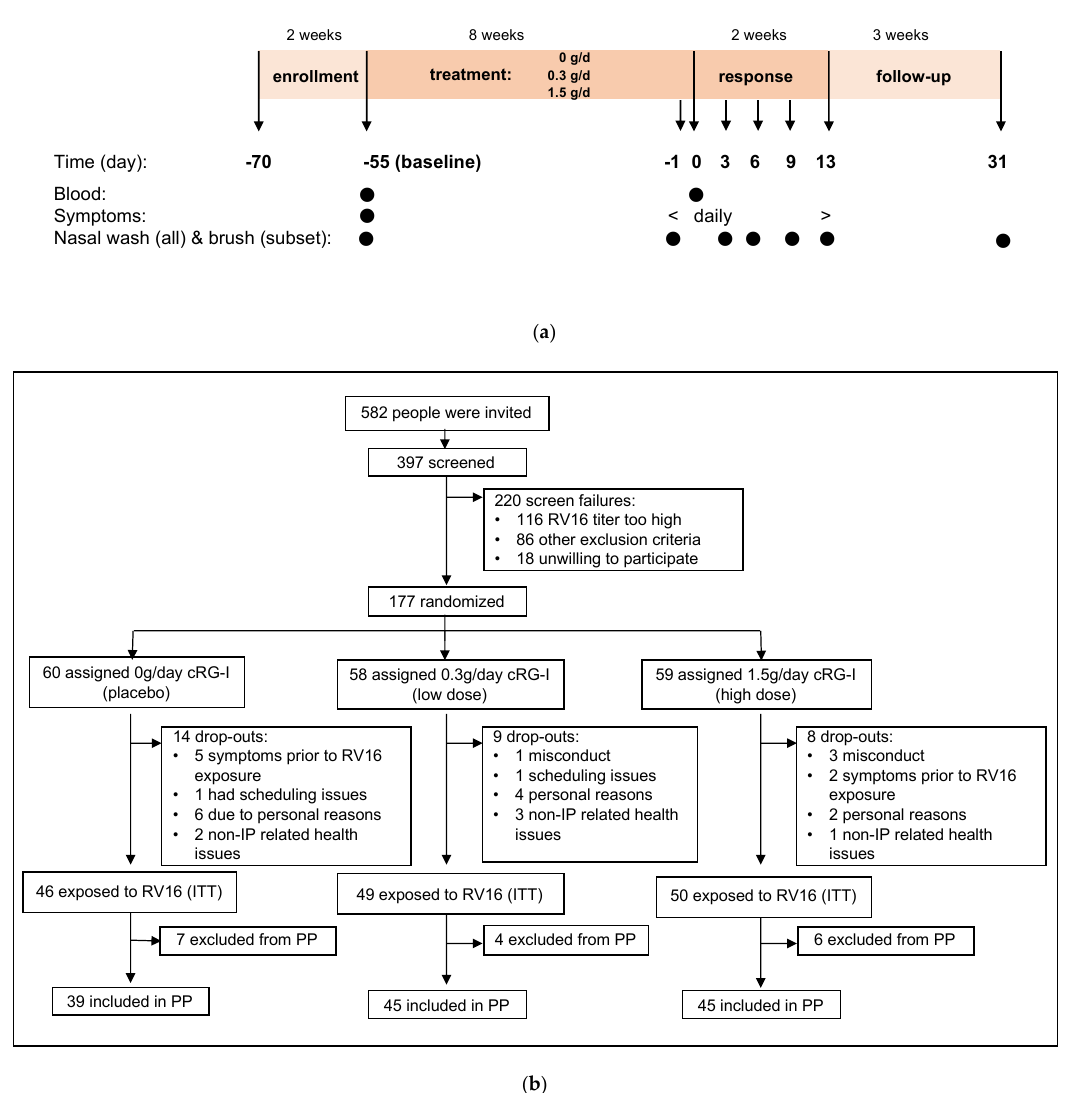
Figure 1. Study design ( a ) and disposition of subjects ( b ). Numbers indicate number of subjects. Unless indicated otherwise, results are indicated for all 146 subjects exposed to RV16 (ITT